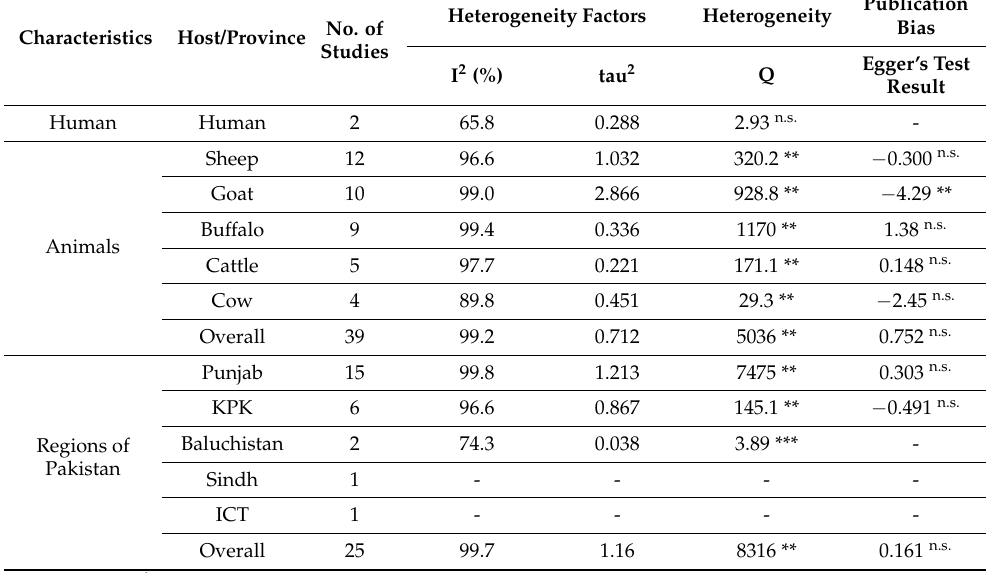
Table 4. Subgroup meta-analysis for comparison of the prevalence of Fasciola spp. in humans and domestic livestock in various geographical regions of